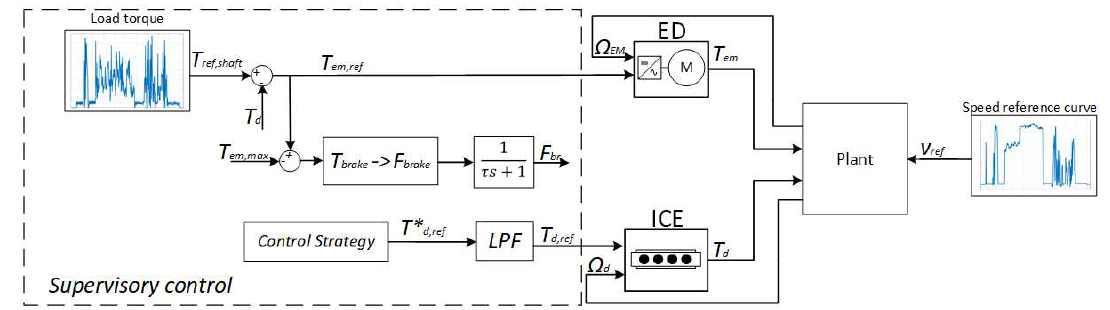
Figure 7: Simulation principle and supervisory control of the parallel HEV